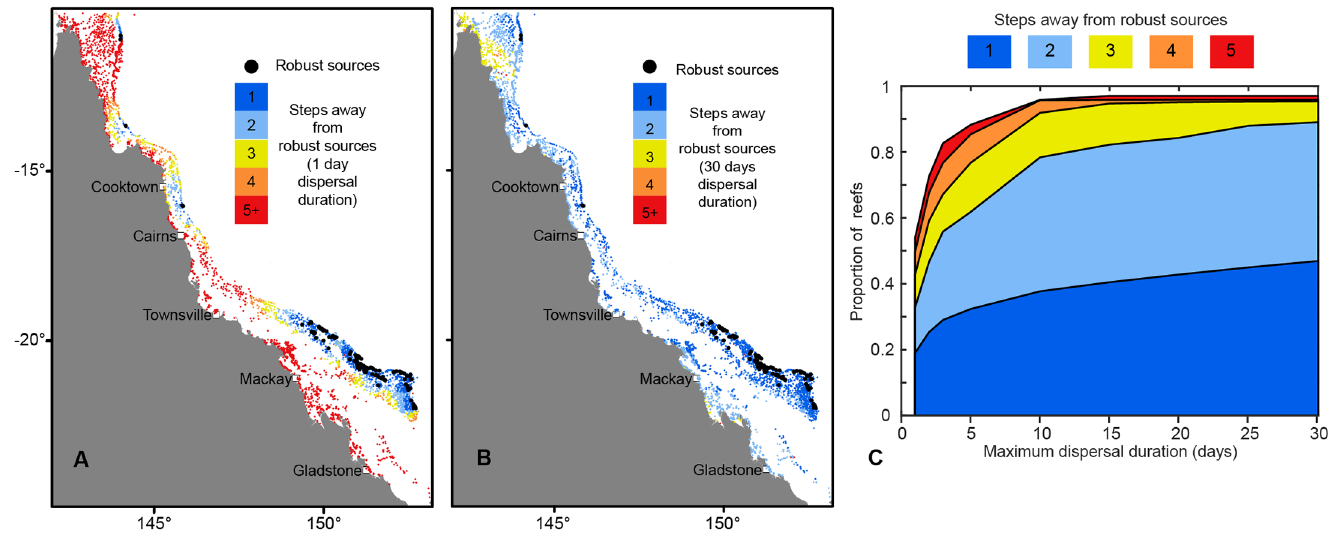
Fig 5. Distance of reefs on the GBR from robust sources in terms of colonisation steps. (A) Number of colonisationsteps neededto reach reefs from robust sources after 1 day of dispersal. (B) Number of colonisation steps neededto reach reefs from robust sources after 30 days of dispersal. (C) Percentage of reefs that can be reachedin a given number of consecutive colonisation steps as a function of maximum dispersalduration(measuredin days since release). Values for a singlecolonisation step correspond to direct links. After 30 days of dispersal, > 80% of the reefs were within 2, and > 95% of the reefs were within 5, colonisation steps away from robust sources. Data providedin S1 Data. GBR, Great Barrier Reef.